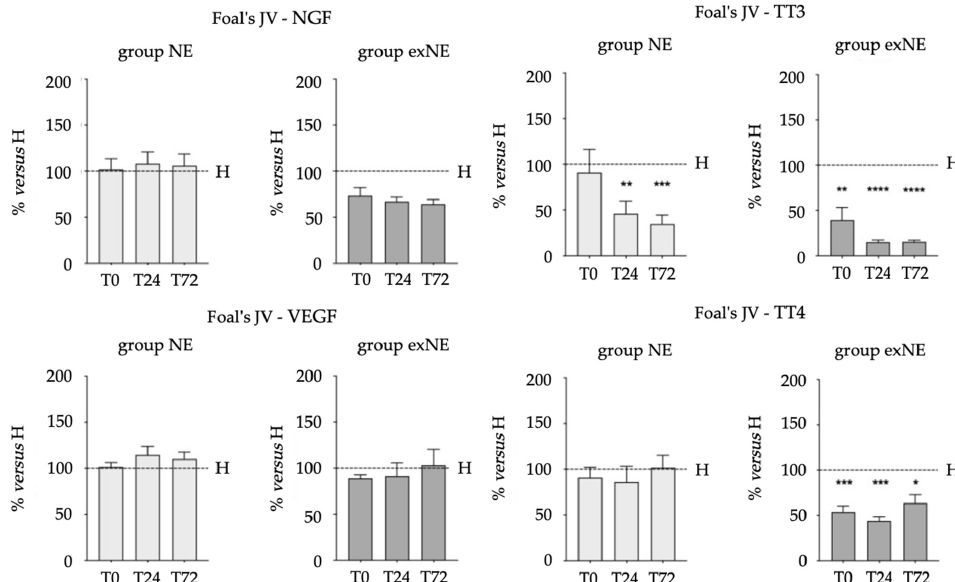
Figure 1. Biomarkers comparison between NE and exNE groups versus H group. Levels in samples obtained from foal’s jugular vein at three consecutive time points (T0: birth/admission; T24: h from birth/admission; T72: h from birth/admission) are expressed as percentage of the mean of the results obtained in the healthy group at each time point. * p < 0.05; ** p < 0.01; *** p < 0.005; **** p < 0.001.